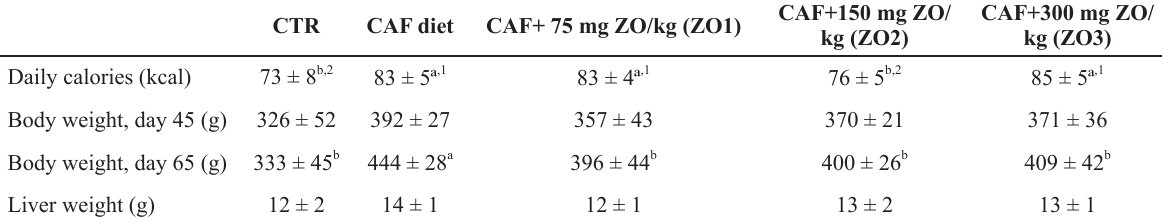
Caloric intake and body and liver weights in the different experimental